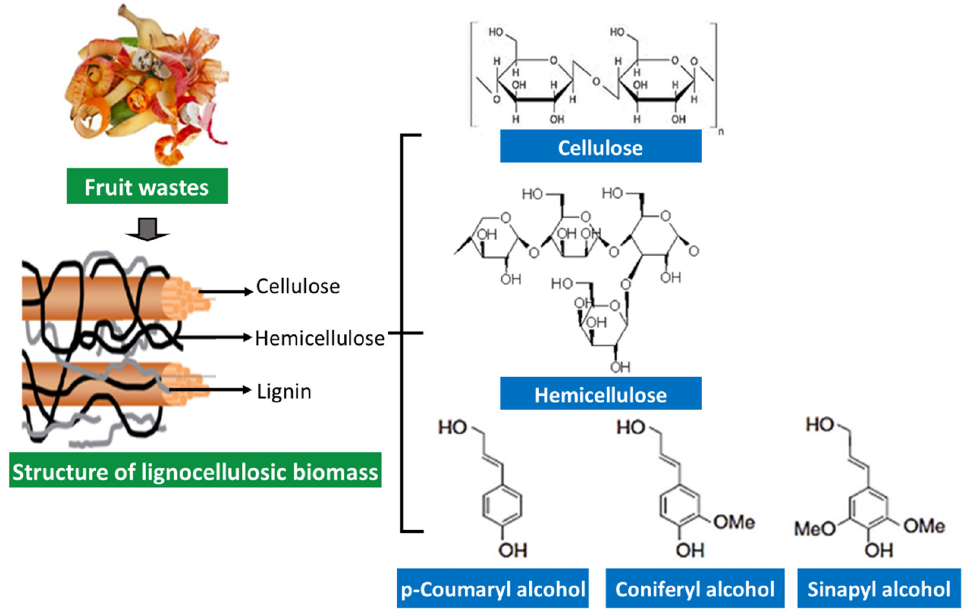
Figure 2. Structural components of lignocellulosic biomass.